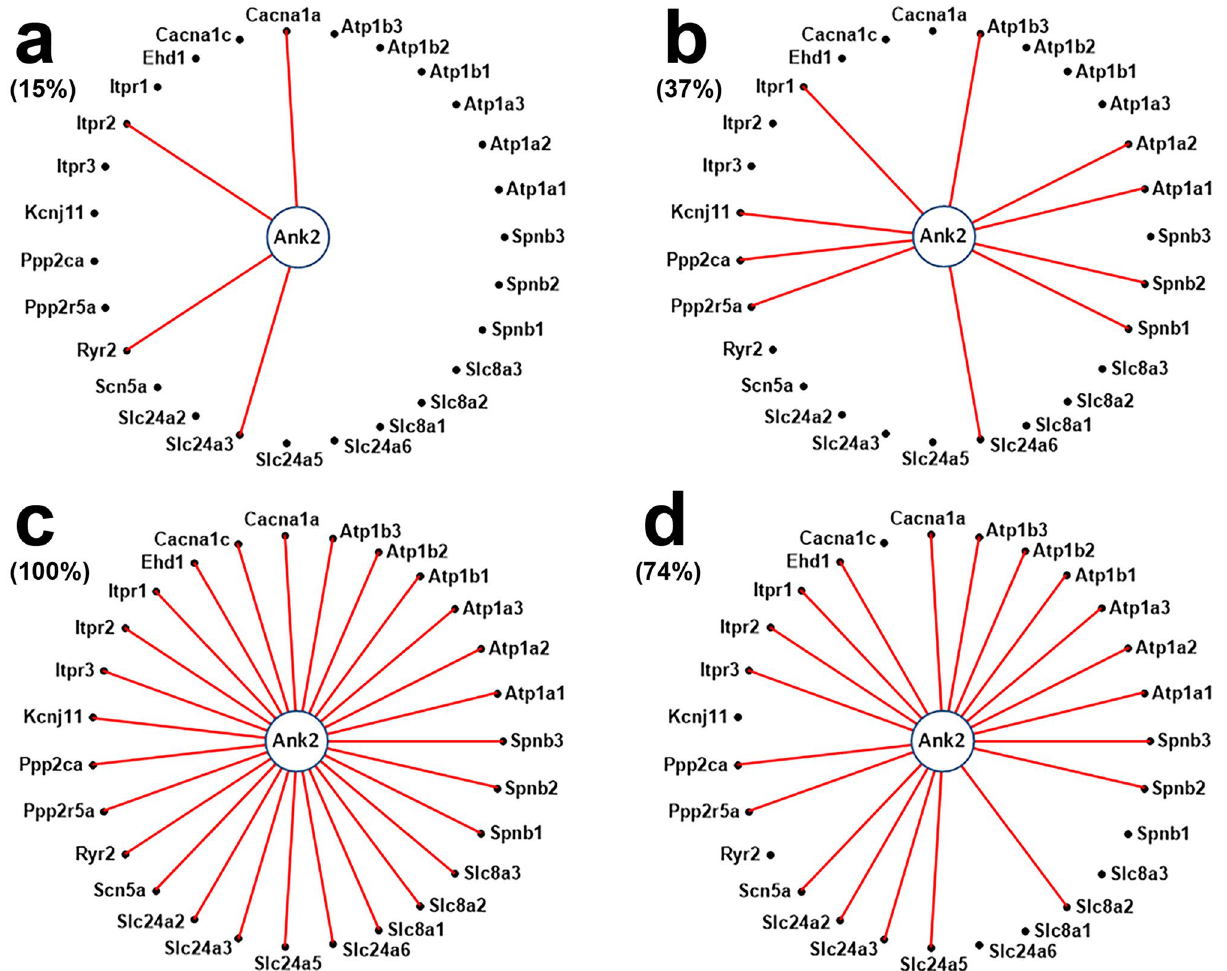
Figure 9. Expression coordination of Ank2 with its known binding partners in: ( a ) left atrium, ( b ) right atrium, ( c ) left ventricle, ( d ) right ventricle. Genes: Atp1a1/2/3 (ATPase, Na + /K + transporting, alpha 1/2/3 polypeptide), Atp1b1/2/3 (ATPase, Na + /K + transporting, beta 1/2/3 polypeptide), Cacna1a (calcium channel, voltage-dependent, P/Q type, alpha 1A subunit), Cacna1c (calcium channel, voltage-dependent, L type, alpha 1C subunit), Ehd1 (EH-domain containing 1), Itpr1/2/3 (inositol 1,4,5-trisphosphate receptor 1/2/3), Kcnj11 (potassium inwardly rectifying channel, subfamily J, member 11), Ppp2ca (protein phosphatase 2 (formerly 2A), catalytic subunit, alpha isoform), (protein phosphatase 2, regulatory subunit B (B56), alpha isoform), Ryr2 (ryanodine receptor 2, cardiac), Scn5a (sodium channel, voltage-gated, type V, alpha), Slc24a2/3/5/6 (solute carrier family 24 (sodium/potassium/ calcium exchanger), member 2/3/5/6), Slc8a1/2/3 (solute carrier family 8 (sodium/calcium exchanger), member 1/2/3), Spnb1/2/3 (spectrin beta